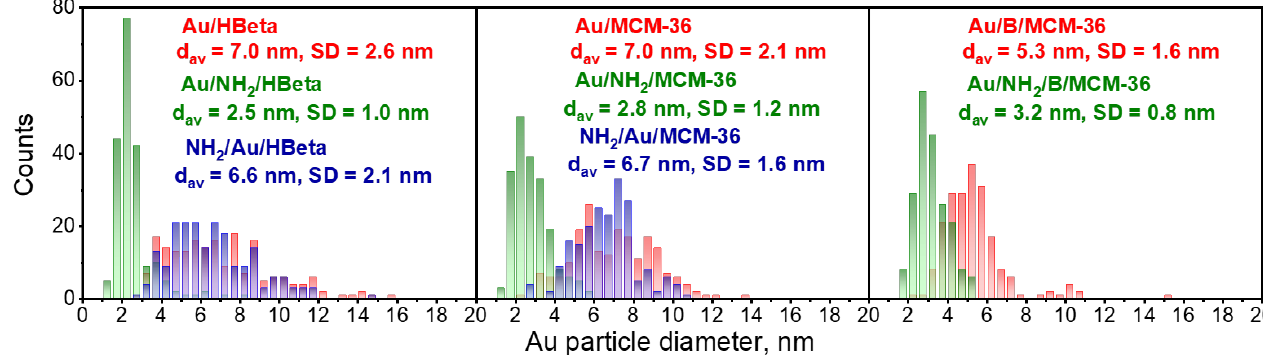
Figure 4. Gold particle size distribution histograms of the catalysts. The values of mean Au NPs diameter (d av ) and standard deviation (SD) were included. The number of particles measured was 200 in each case.